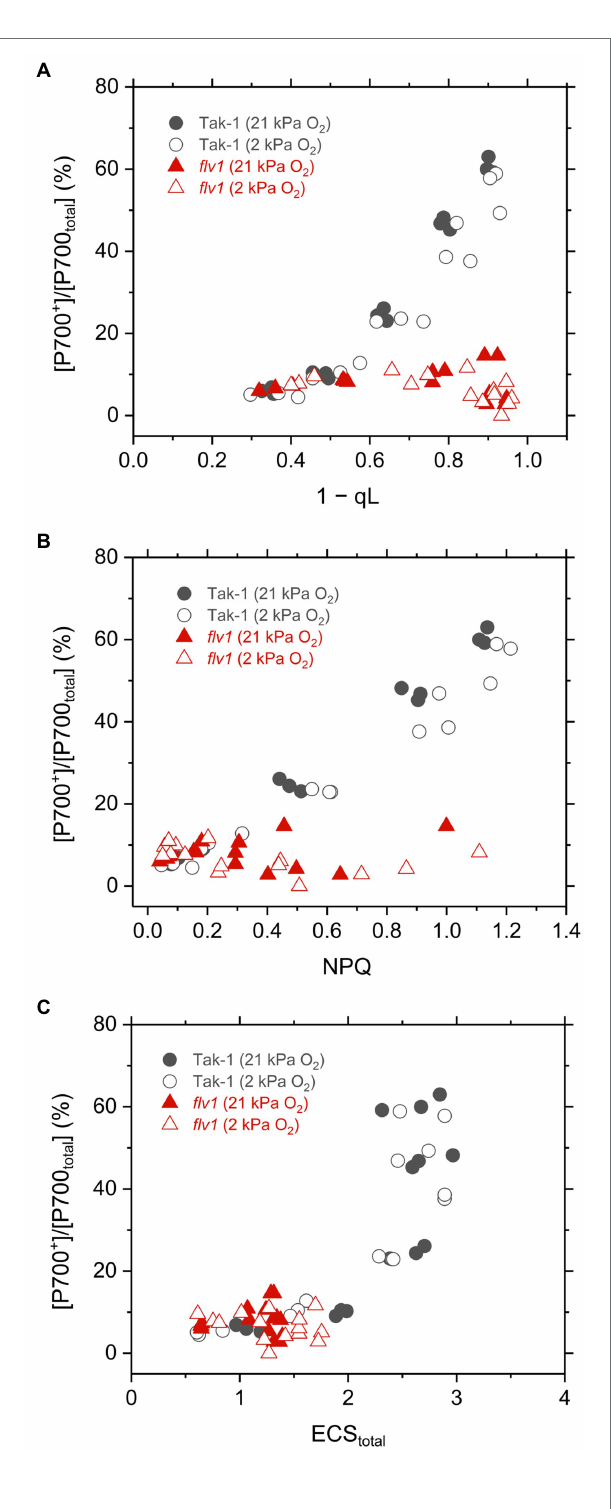
FIGURE 7 | Relationships of P700 oxidation with inferred reduction level of plastoquinone pool (1 − qL; A ), NPQ (B) , and thylakoid membrane potential reflected in ECS total (C) in the liverwort M. polymorpha (Tak-1; black circles) and the mutant flv1 (red triangles). Experiments were performed under 21 (closed symbols) and 2 kPa O 2 (open symbols). Data are derived from three independent measurements in Figures 3 , 4 , and 6